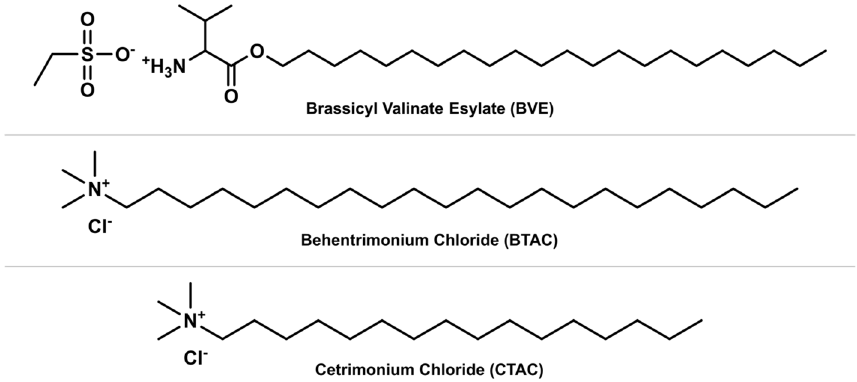
Figure 10. Chemical structures of cationic amino lipid surfactant brassicyl valinate esylate (BVE) and alkyl quaternary ammonium surfactants behentrimonium chloride (BTAC) and cetrimonium chloride (CTAC).